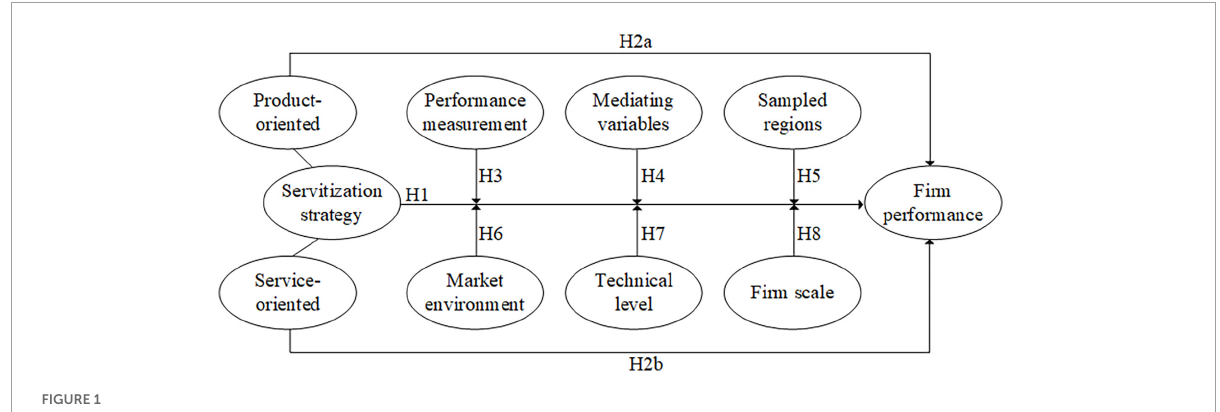
FIGURE1 Theoretical model of influencing